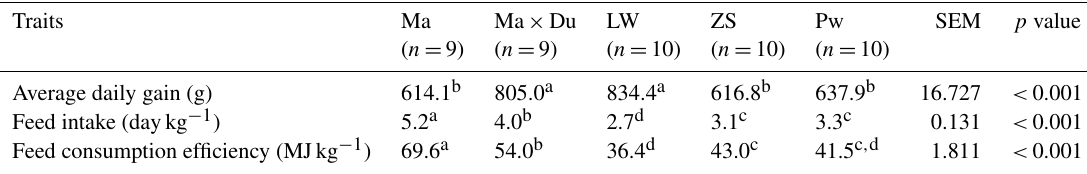
Table 4. Fattening parameters of genotypes. Traits Ma Ma × Du LW ZS Pw SEM p value ( n = 9) ( n = 10) ( n = 10) ( n = 10) Average daily gain (g) 614.1 b